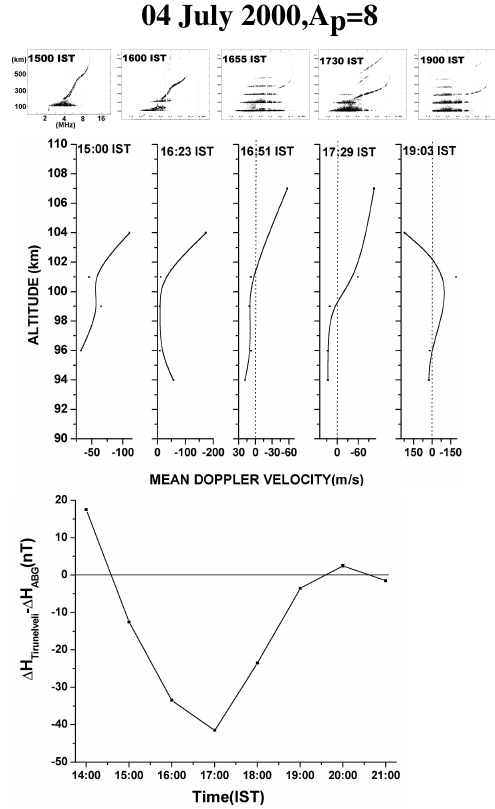
Fig. 10a. Same as Fig. 9a, but for 4 July 2000.